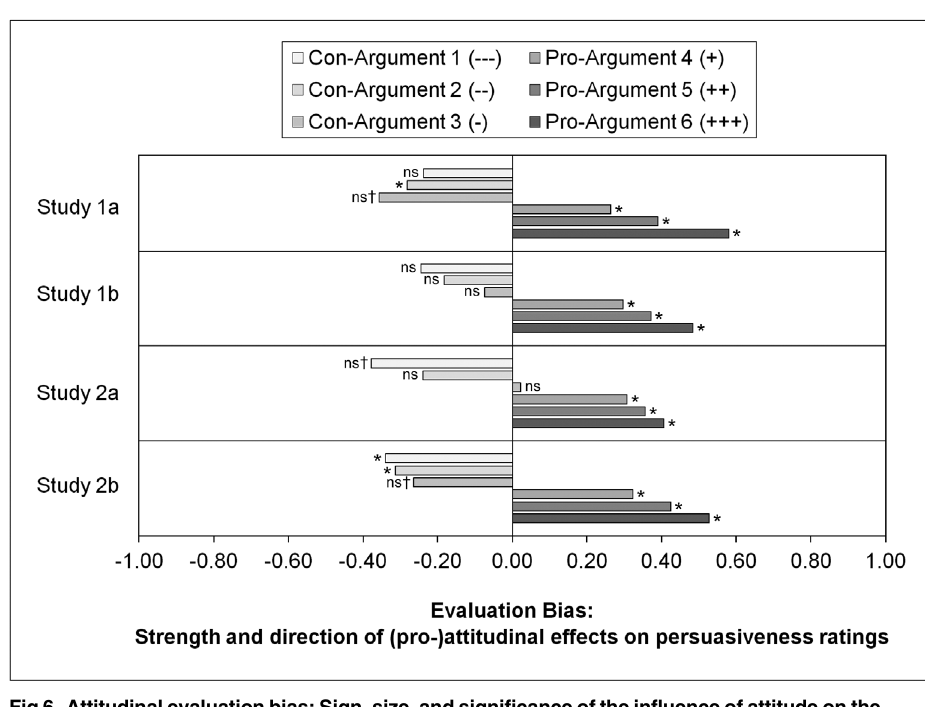
Fig 6. Attitudinal evaluation bias: Sign, size, and significance of the influence of attitude on the persuasiveness ratings for each argument for each of the four studies. ( * ) Bayesian 99% credibility interval for evaluation bias does not contain the value of zero (significant). (ns) Bayesian 99% credibility interval contains the value of zero (not significant). ( † ) A 95% credibility interval would not contain the value of